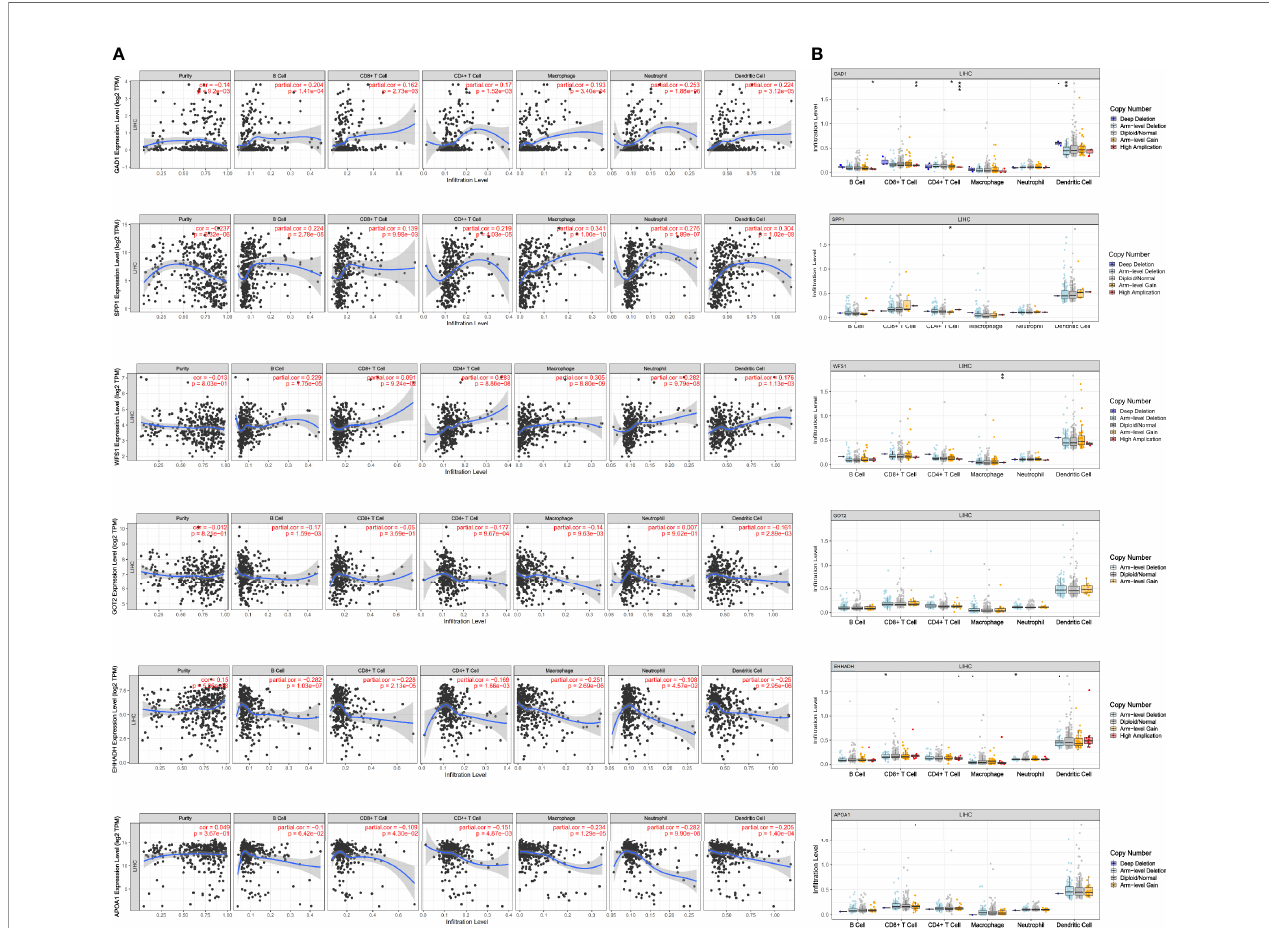
FIGURE 10 | Association of mRNA expression of six MRGs with immune in fi ltration level in HCC. (A) Correlation of MRGs including GAD1, SPP1, WFS1, GOT2, EHHADH, and APOA1 with tumor purity and in fi ltration of B cells, CD8+ T cells, CD4+ T cells, macrophages, neutrophils, and dendritic cells. (B) The in fl uence of copy number variation of GAD1, SPP1, WFS1, GOT2, EHHADH, and APOA1 on the distribution of diverse immune cells. *p < 0.05; **p < 0.01; ***p <